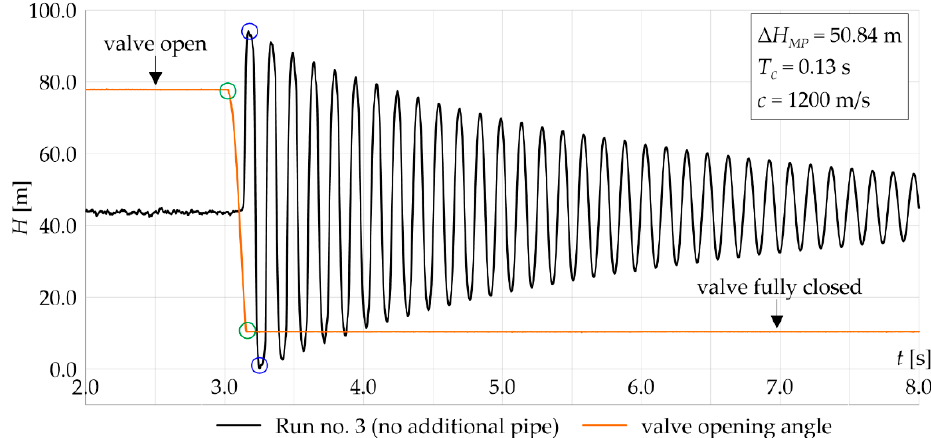
Figure 4. Pressure oscillations recorded during run no. 3 (data obtained with sensor P M ).